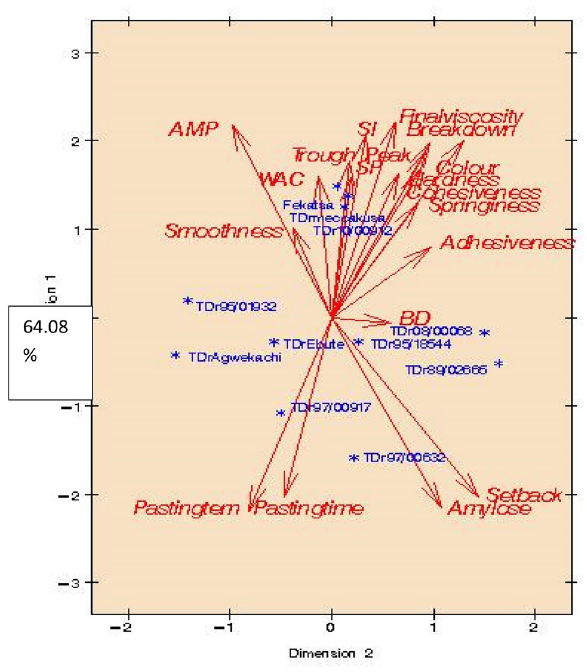
Figure 3. Principal Component Analysis of flour physicochemical with the fufu product pasting and sensory attributes from D. rotundata control and improved